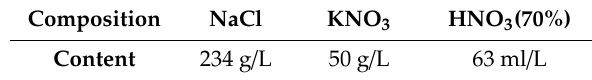
Table 3. Composition and ratio of exfoliation corrosion (EXCO)